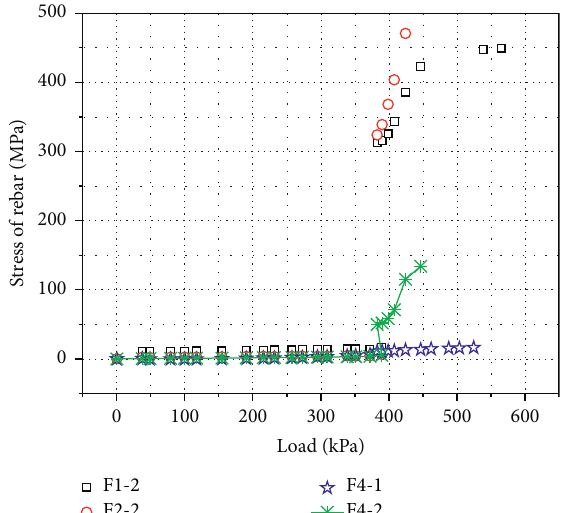
Figure 14: Load-stress curve of bottom